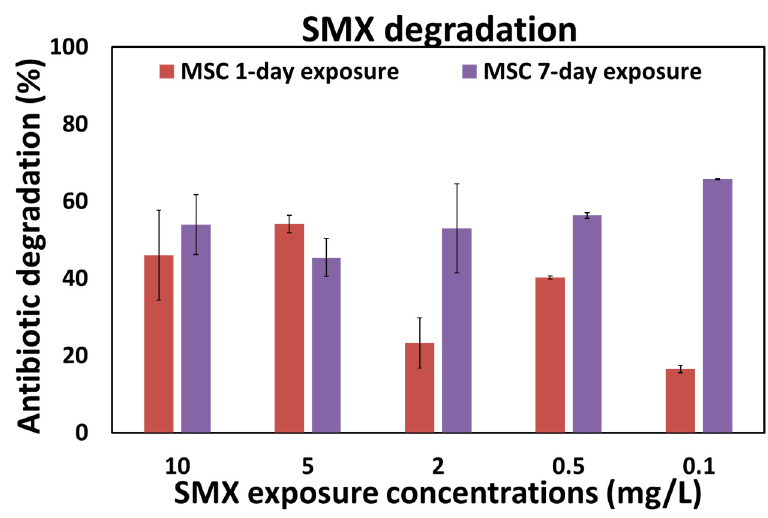
Figure 2. SMX degradation (%) in MSC experiments at one-day (acute experiment) and seven-day exposure (chronic exposure). n.d.: not detected. The vertical bars represent the standard errors.